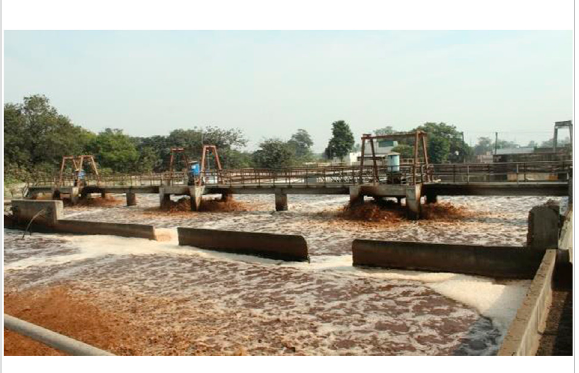
FIGURE 7 The aeration tank over fl ow is processed further with a secondary clari fi er to remove suspended active biomass.